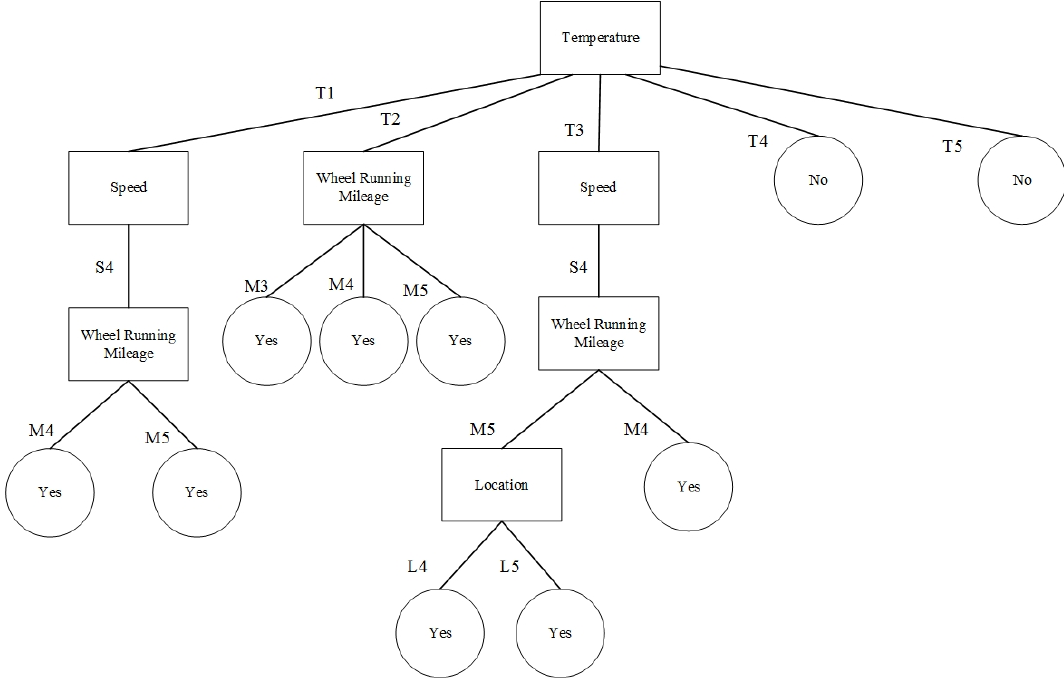
Figure 5. A decision tree to determine whether maintenance is needed following a BIDS alarm.